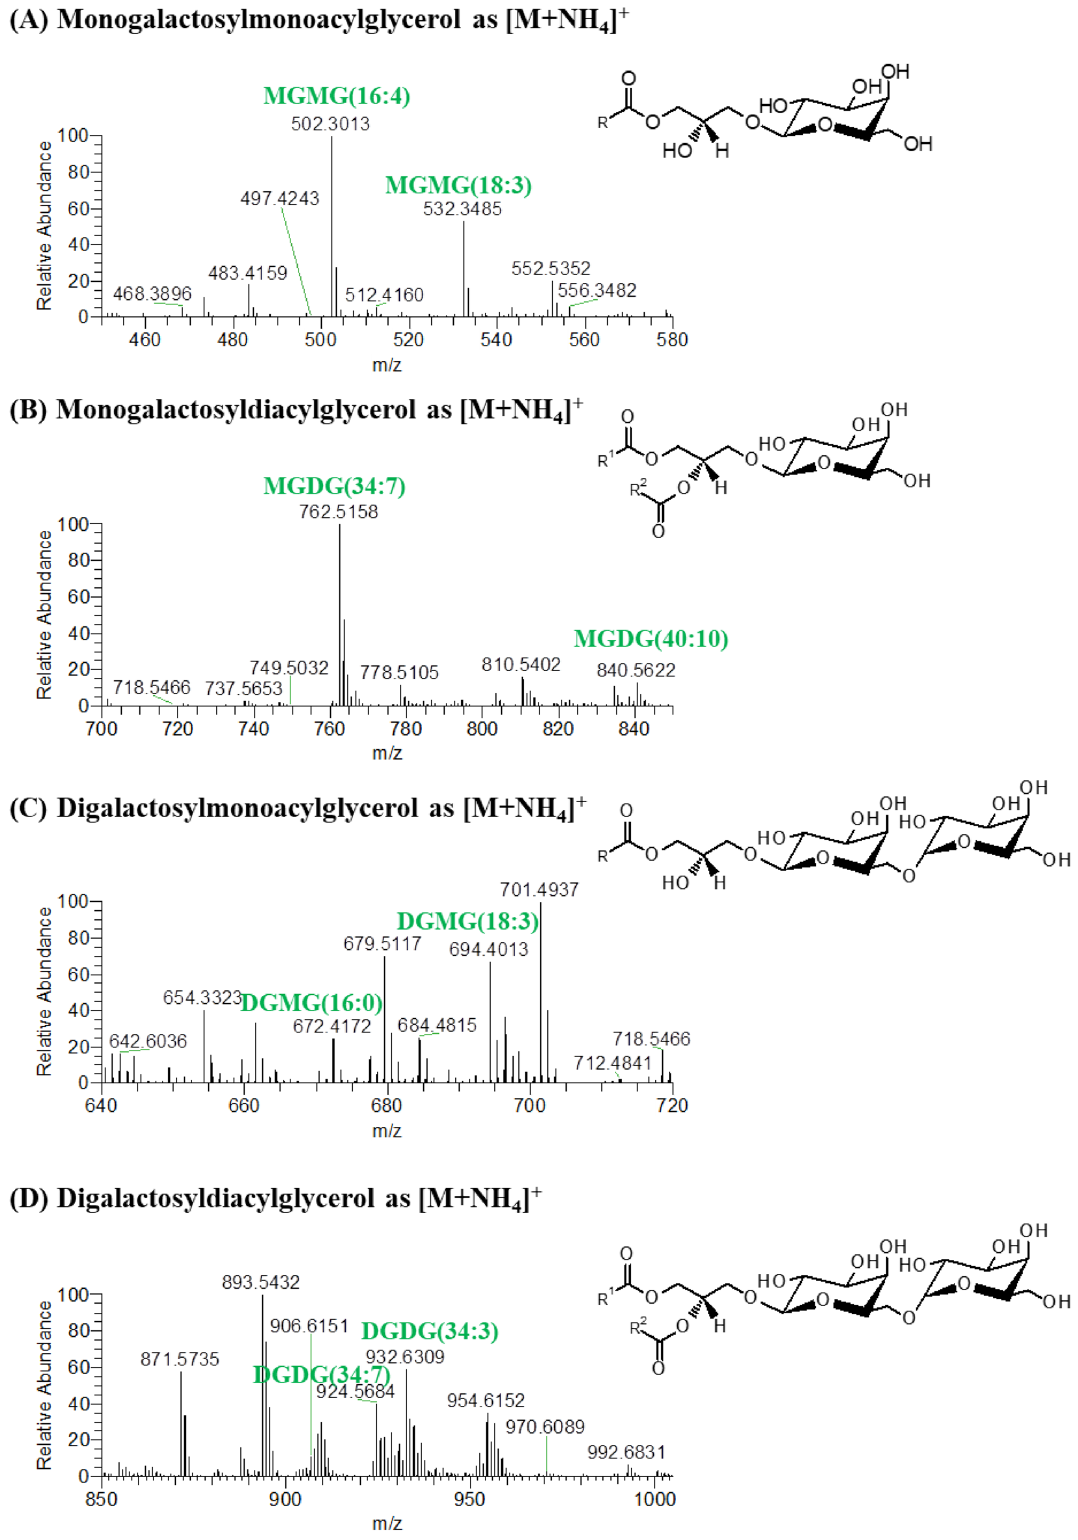
Figure 4. HILIC–HR–ESI–MS spectra of the classes of glycolipids (GL) identified in positive ion mode as [M+NH 4 ] + . These classes were ( A ) monogalactosylmonoacylglycerol (MGMG), ( B ) monogalactosyldiacylglycerol (MGDG), ( C ) digalactosylmonoacylglycerol (DGMG) and ( D ) digalactosyldiacylglycerol